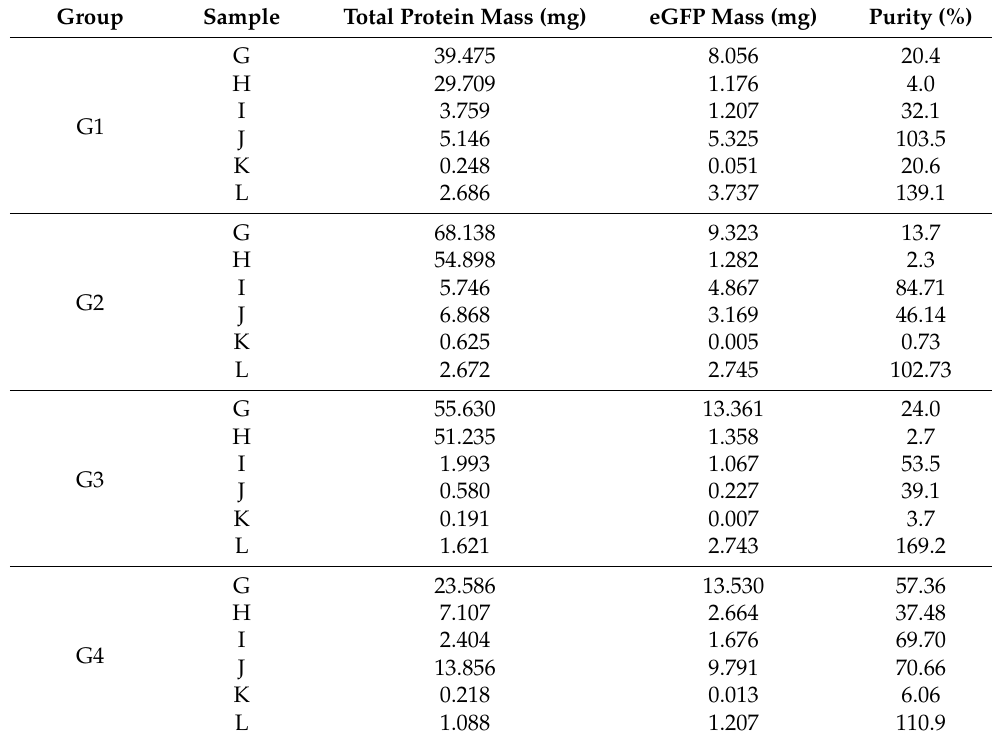
Table 4. Mass balance and eGFP purity for each working